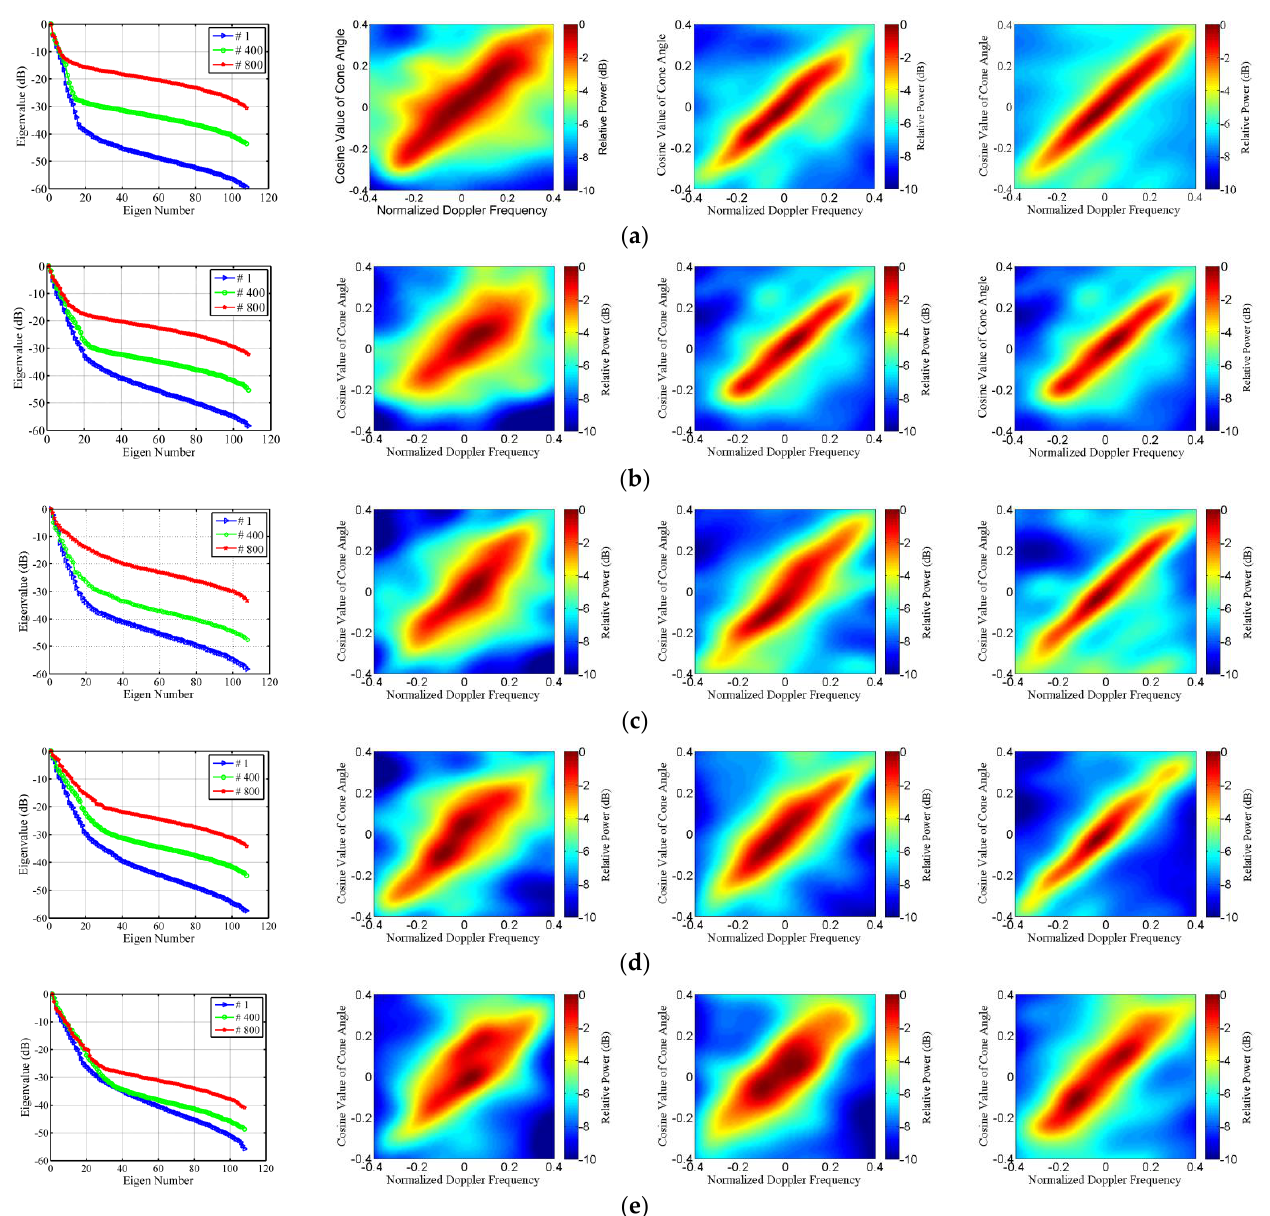
Figure 10. Eigenvalue spectrum and space-time power spectrum corresponding to different range gates (#1; #400; #800) under each sea state: ( a ) sea state 1; ( b ) sea state 2; ( c ) sea state 3; ( d ) sea state 4; and ( e ) sea state 5.